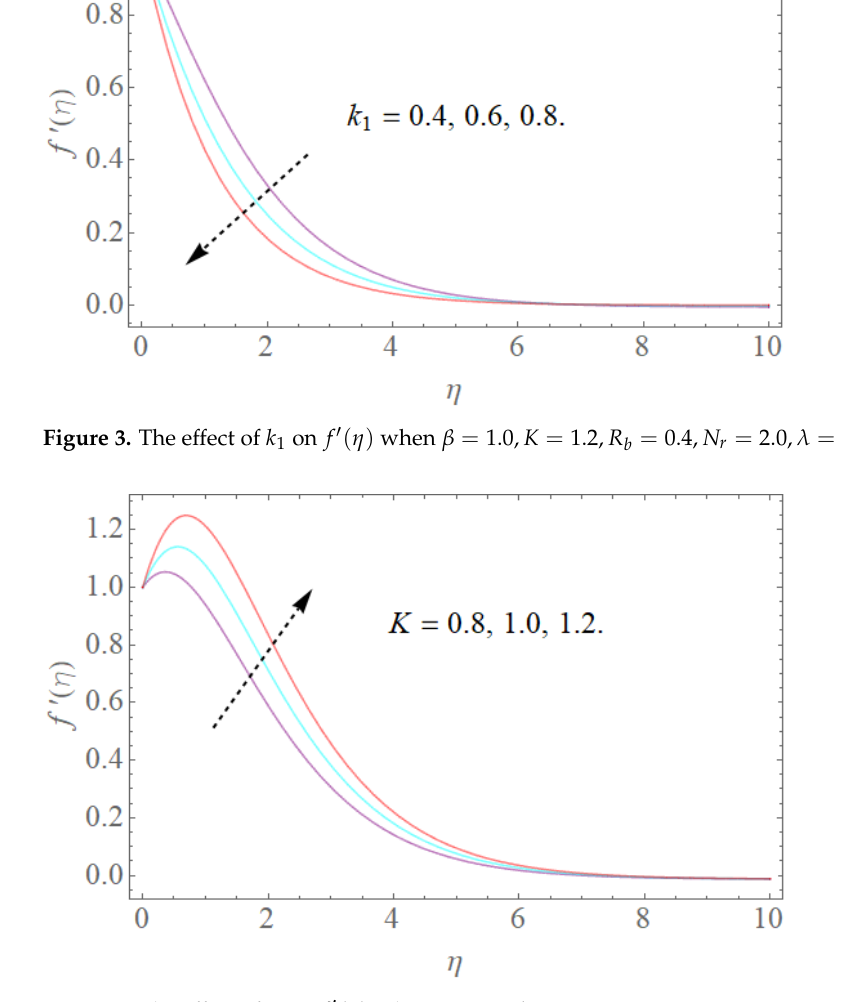
Figure 4. The effect of K on